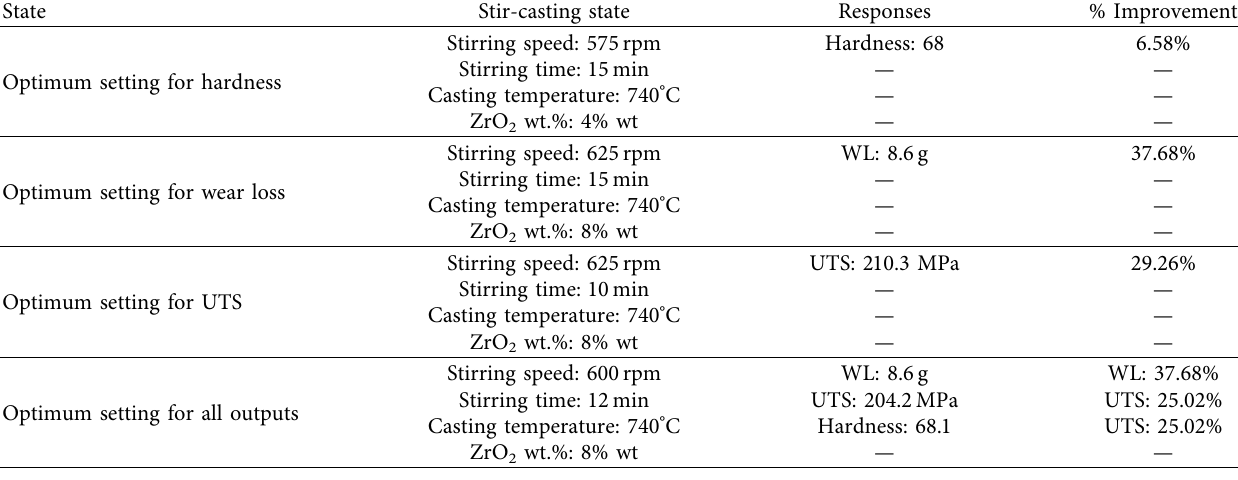
Table 6: Validation of experimental outcome for optimum settings of stir-casting progression.